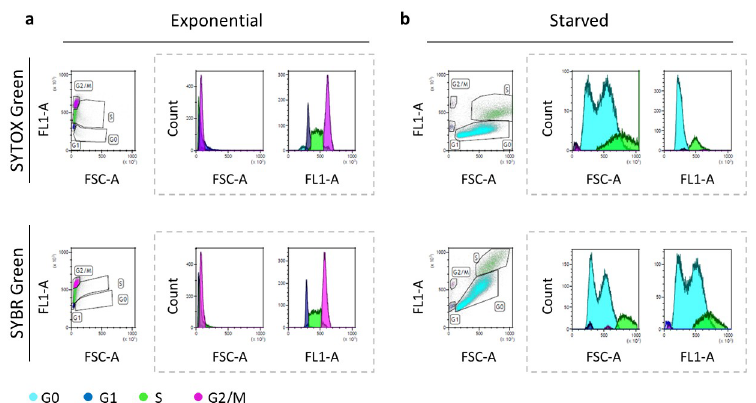
Fig 3. Flow cytometric analysis of S. cerevisiae cells from a batch culture, during exponential (a) and final starvation (b) phases, stained with SYTOX Green and SYBR Green dyes. Dashed rectangles group the mono- dimensional analysis of forward scatter signal (FSC-A) and green fluorescence (FL1-A), representing cell size and DNA content per cell, respectively, vs cell count. In the dot plots on the right of each panel, G0, G1, S, and G2/M cell cycle stages are identified according to both FSC-A and